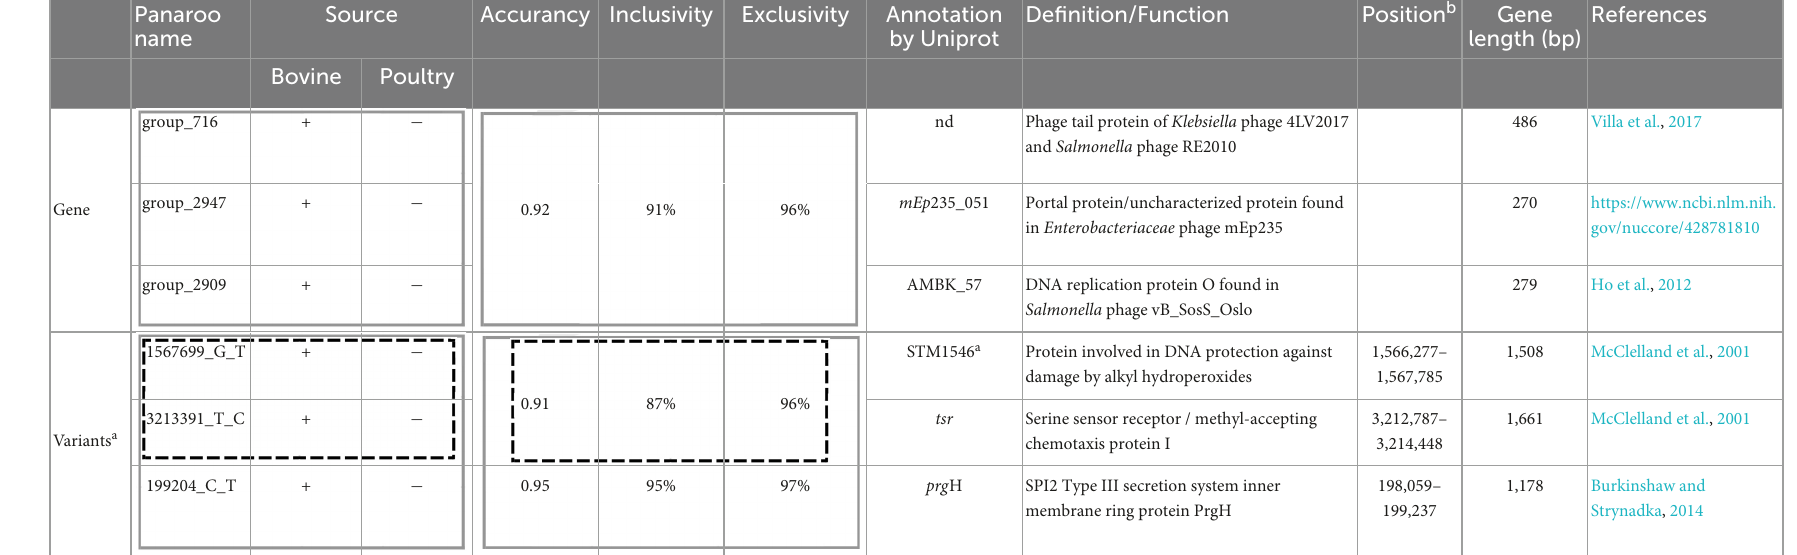
TABLE 1 Duo and trio combinations of genes and variants for host identification (bovine and poultry) within S . Mbandaka strains of sequence type ST413 from France. Panaroo